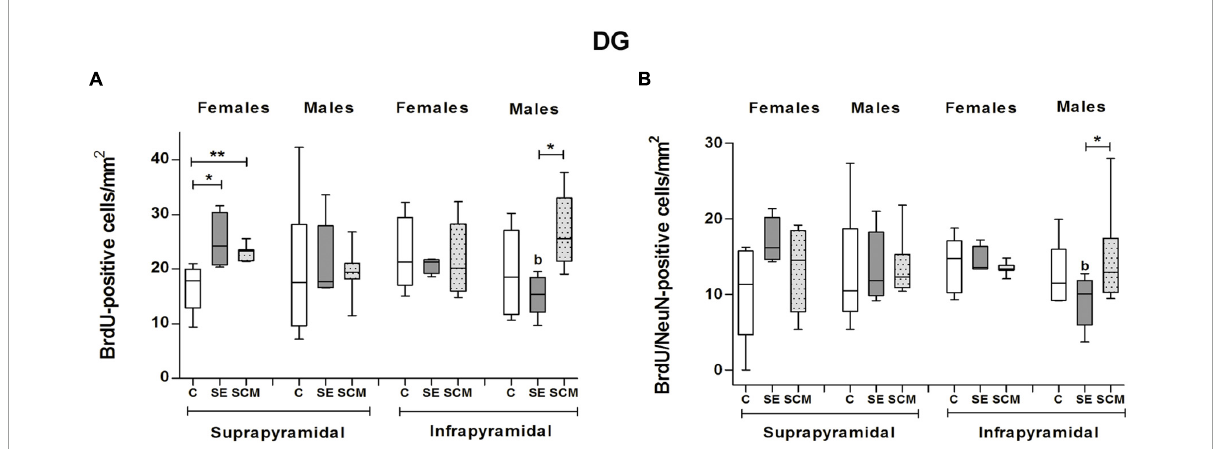
FIGURE8 Data analysis of the number of BrdU and BrdU/NeuN-positive cells in the suprapyramidal and infrapyramidal blades of the DG for Control (C), Social exposure to a conspecific (SE) and Social cohabitation with mating (SCM) female and male prairie voles Kruskal-Wallis followed by Dunn’s post-hoc tests; * p < 0.05 and ** p < 0.01 were considered significant. Differences between females and males were analyzed using the Mann-Whitney U test, a p < 0.05 and b p < 0.01. Female subjects; C = 7, SE = 4, SCM = 7. Male subjects; C = 6, SE = 5, SCM = 7.